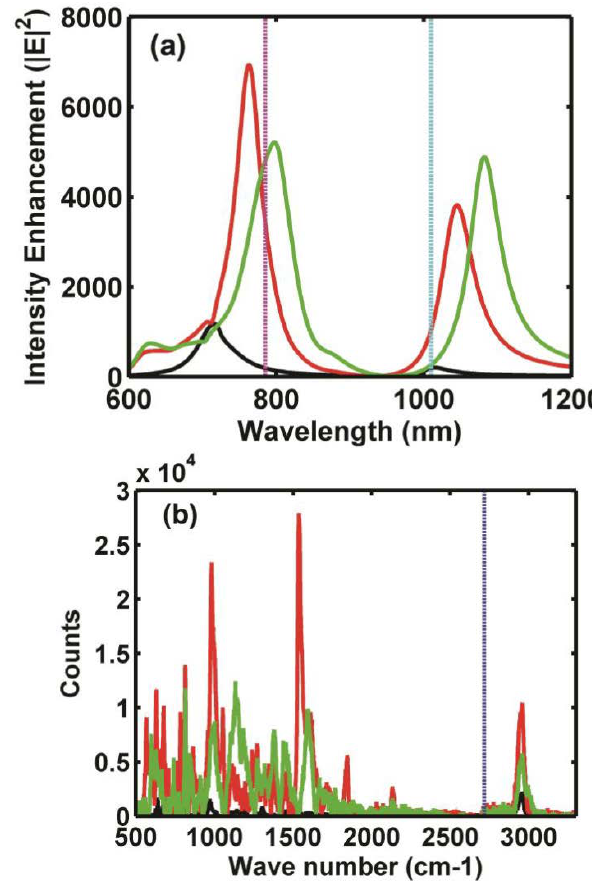
Figure 15: (a) Simulated intensity enhancement spectra. The dashed violet line marks the wavelength of the pump laser and the dashed cyan linemarks the position of the Raman signal at 2960 cm −1 . (b) Measured Raman spectra of PMMA for the three structures in our experiment. The Raman signal with a wave number larger than the blue line position is magnified by four times for clarity. The black, red, and green spectra in (a) and (b) respectively correspond to structure A: L = 100 nm, g = 25 nm, T = 60 nm, θ = 50 ∘ ; struc- ture B: L = 120nm, g = 10 nm, T = 55 nm, θ = 50 ∘ ; and structure C: L = 140 nm, g = 10 nm, T = 60 nm, θ = 50 ∘ . Adapted from Ref.